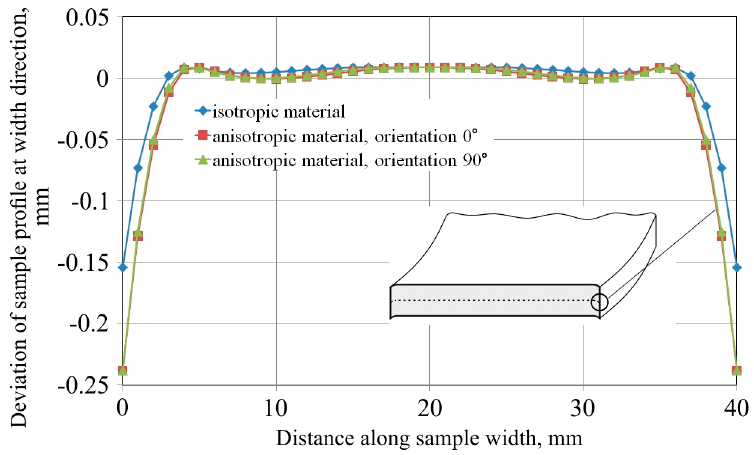
Figure 10. Deviation of the sample profile in width direction.